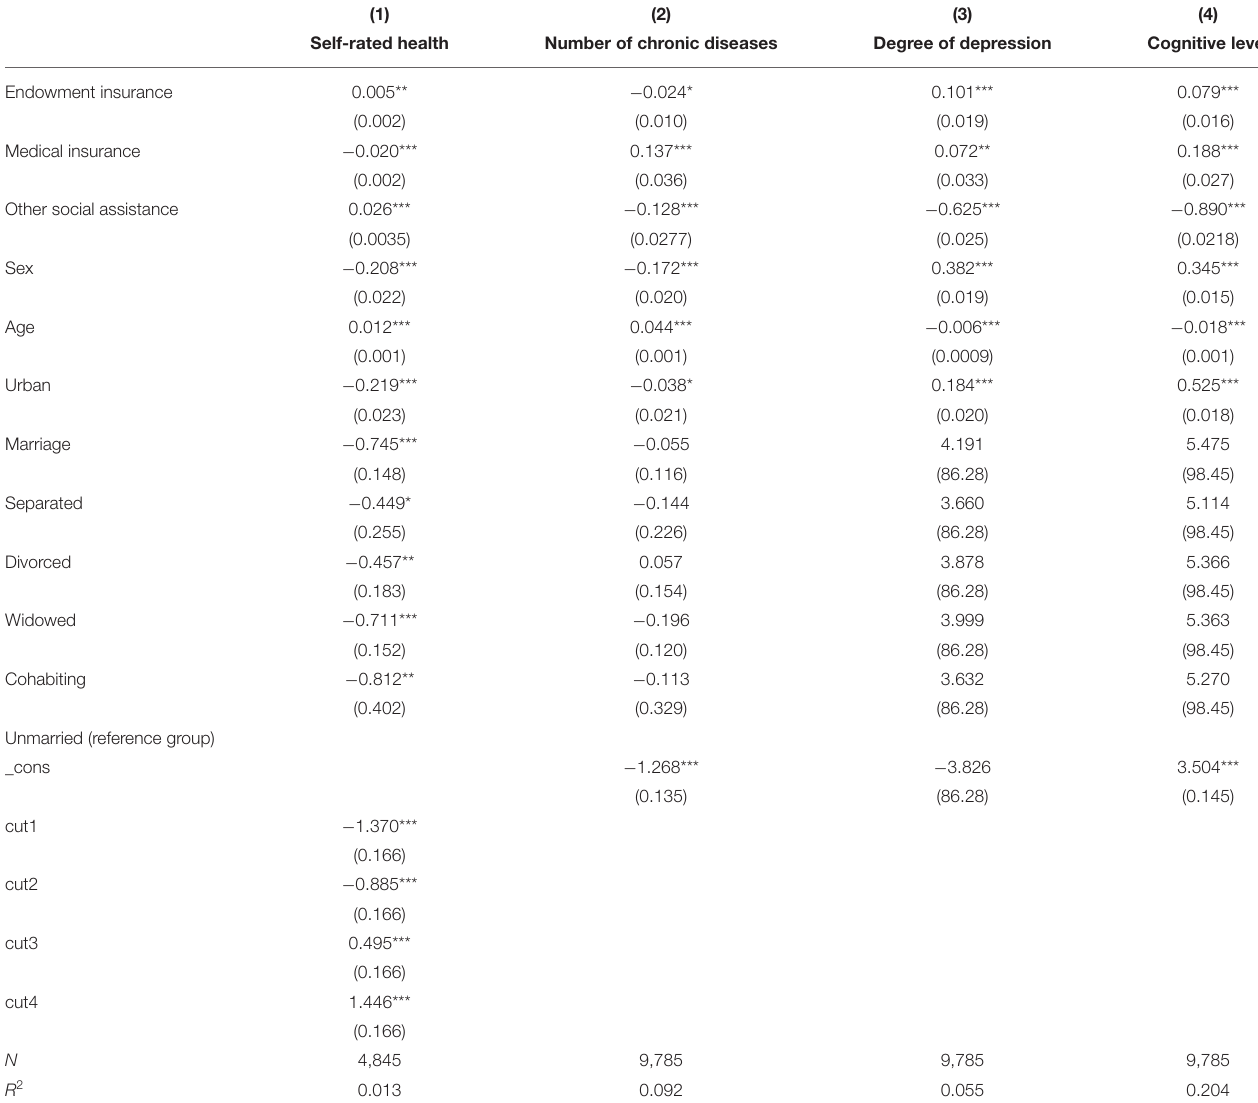
TABLE 1 | Impact of formal social support on the health of older